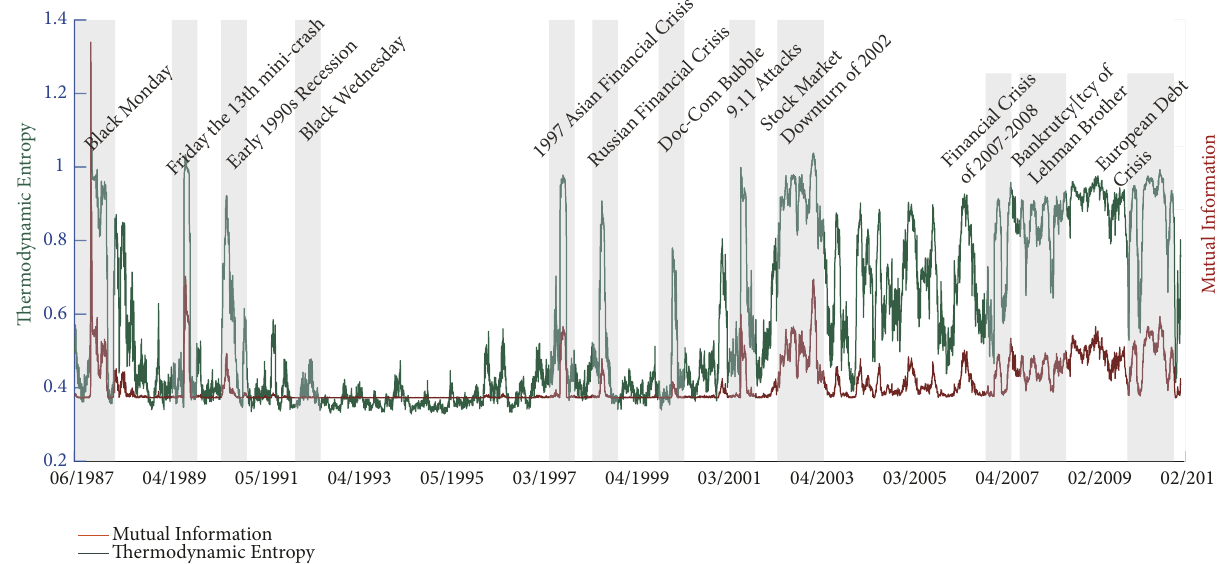
Figure 5: Entropy fluctuation in NYSE (1987-2011). The network structure is derived from traditional pairwise correlation and mutual information. (a) Green line, correlation coefficient; (b) brown line, mutual information.